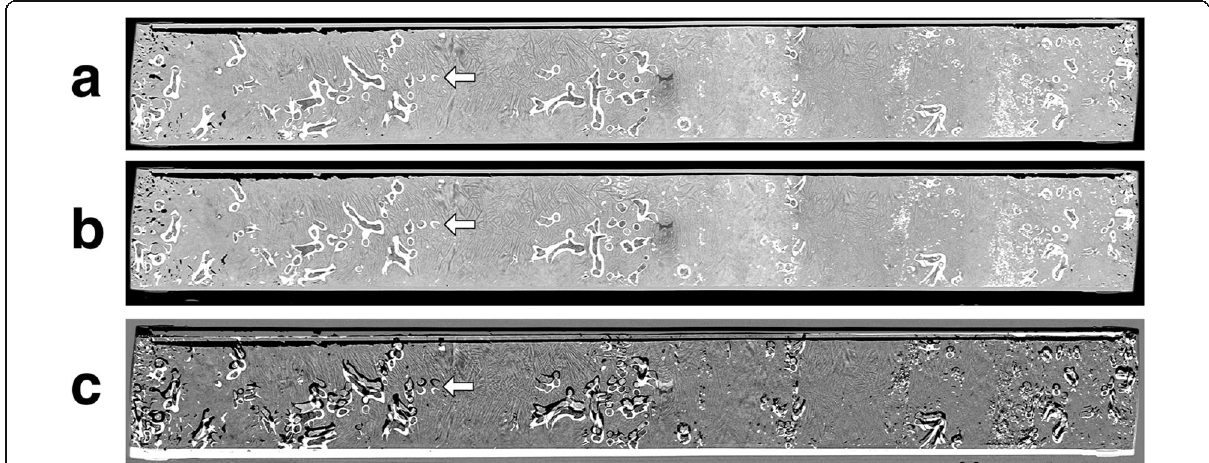
Fig. 6 Examples of sagittal reconstructions of CT acquisitions of sediment cores, which were annotated with a digital ruler (not shown) and used during geological sampling to identify and locate coral fragments below the surface. a Before alignment correction. b After alignment correction. c Difference image before/after alignment correction. Areas with high density before correction and low density after correction are shown in white, areas with low density before correction and high density after correction are shown in black. Note the large differences in sample position in-plane and the smaller differences out-of-plane. For the effect of alignment correction on the sampling process, consider the coral fragment indicated by the arrow. As can be observed from the difference image, trying to sample this fragment at the location indicated by the uncorrected image would completely miss the